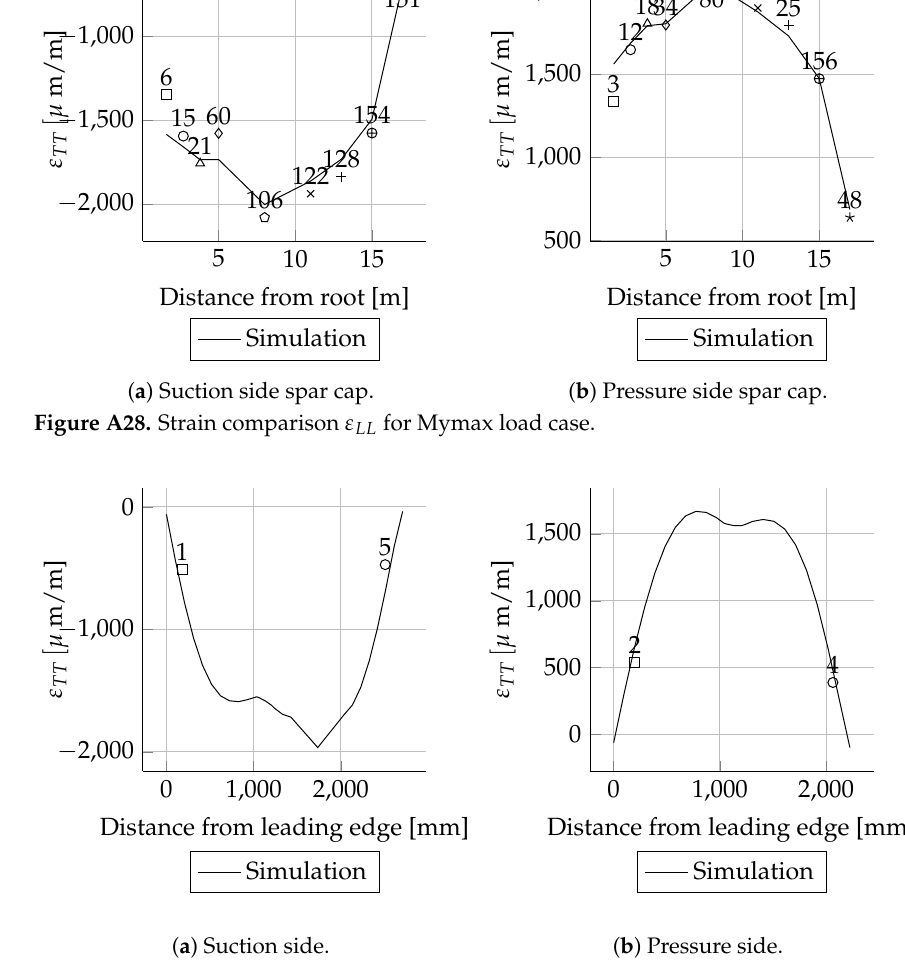
Figure A29. Strain comparison ε LL at radial position R = 1600 mm for Mymax load